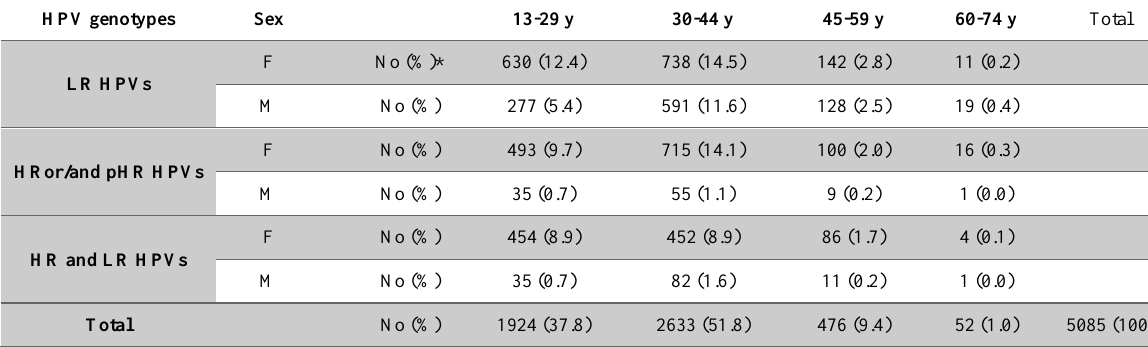
Table 5. Distribution of HPV genotypes by age groups and sex